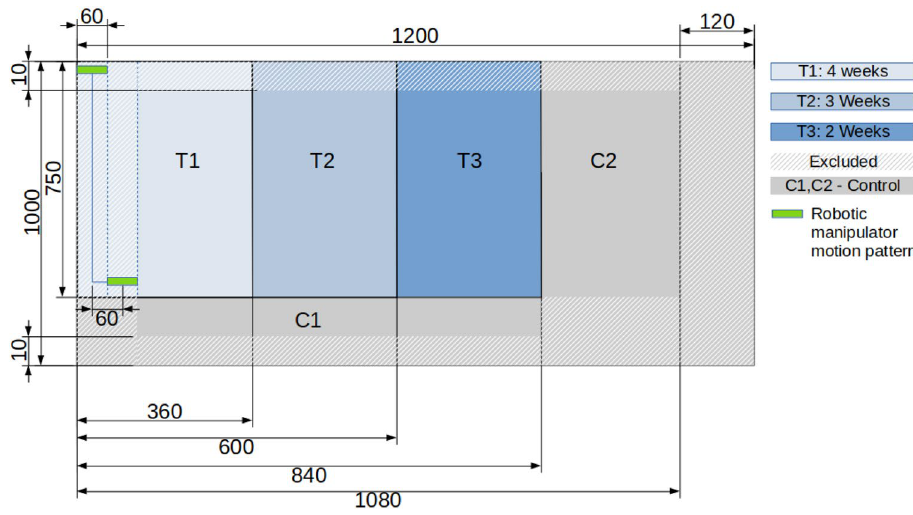
Figure 7. Description of three treatment groups (T) and two control groups (C) of Experiment